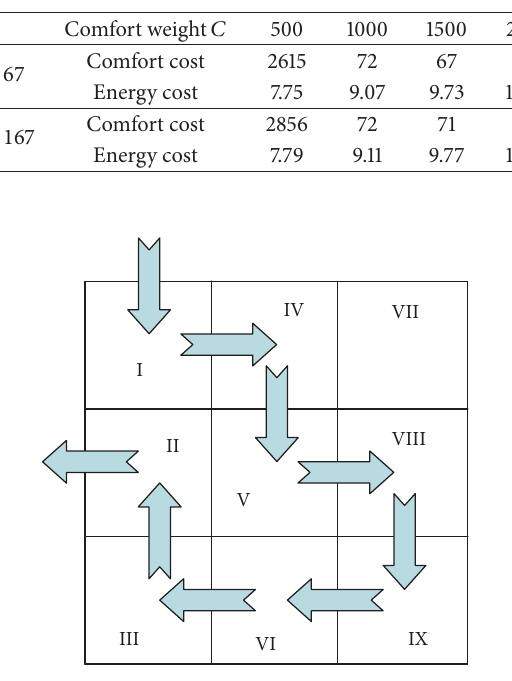
Figure 14: Movement of occupants in cascade (zones I, IV, V, VIII, IX, VI, III, and